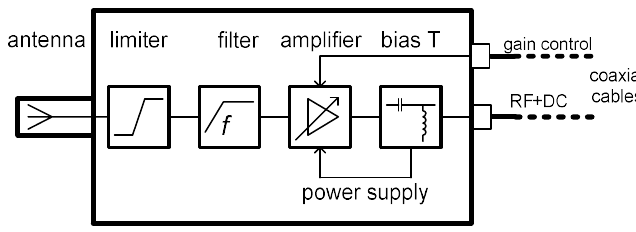
Figure 5. The principal schematic of the PD UHF sensor unit.